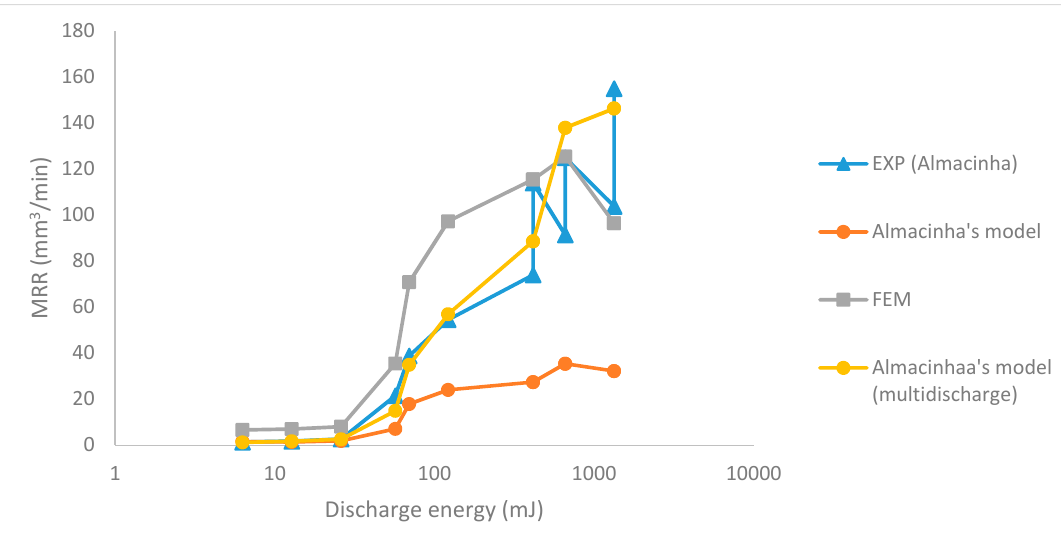
Figure 9. Comparison of MRR obtained from our numerical model with experimental values from Dibitonto [7] (discharge voltage 25 V).